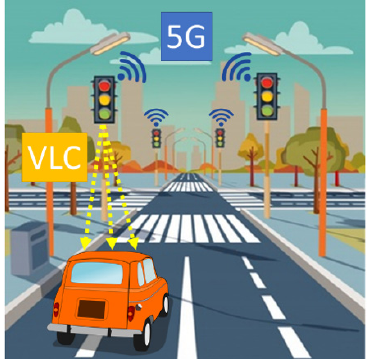
Figure 1. VLC-5G network topology.